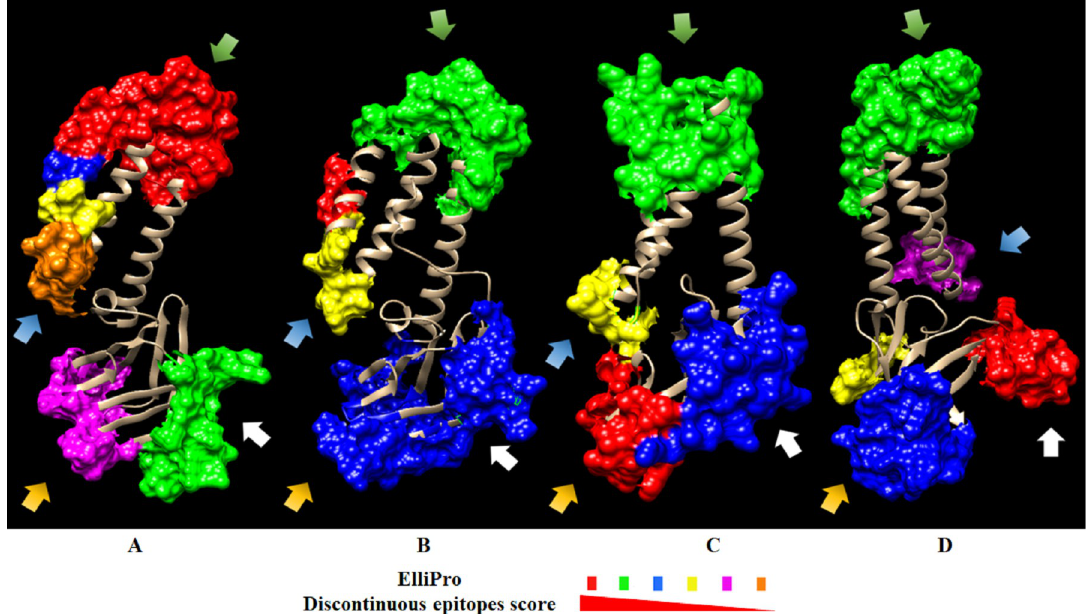
Fig 4. Discontinuous epitopes predicted in ElliPro from CV777, 2013MMV and SARS-CoV-2 M protein models. A) CV777 M protein. B) 2013MMV M protein. C) SARS-CoV-2 M protein from AlphaFold. D) SARS-CoV-2 M protein from Feig lab. Predicted discontinuous epitopes are highlighted in the 3D model with different colors to represent the score. The epitope with the highest score is represented in red up to the lowest value in orange. The score decreases from the epitopes marked in green, blue, yellow, and pink. Arrows with the same color indicate discontinuous epitopes located in equivalent regions in the models. Colored residues in each epitope are indicated in S2 Table.